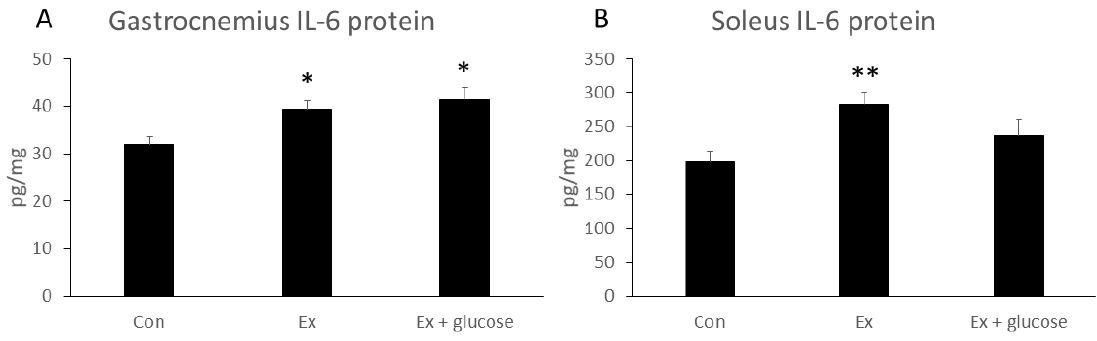
Figure 3. Effects of exercise and glucose ingestion on IL-6 protein concentration in ( A ) gastrocnemius and ( B ) soleus. The data are presented as means ± SE. * p < 0.05, ** p < 0.01 compared to Con.